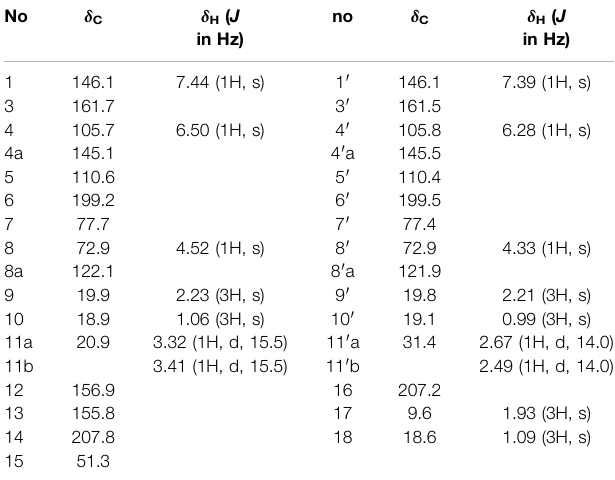
TABLE1| 1 H(500 MHz)and 13 C(125 MHz)NMRDataofCompound 3 inCD 3 OD ( δ in ppm).